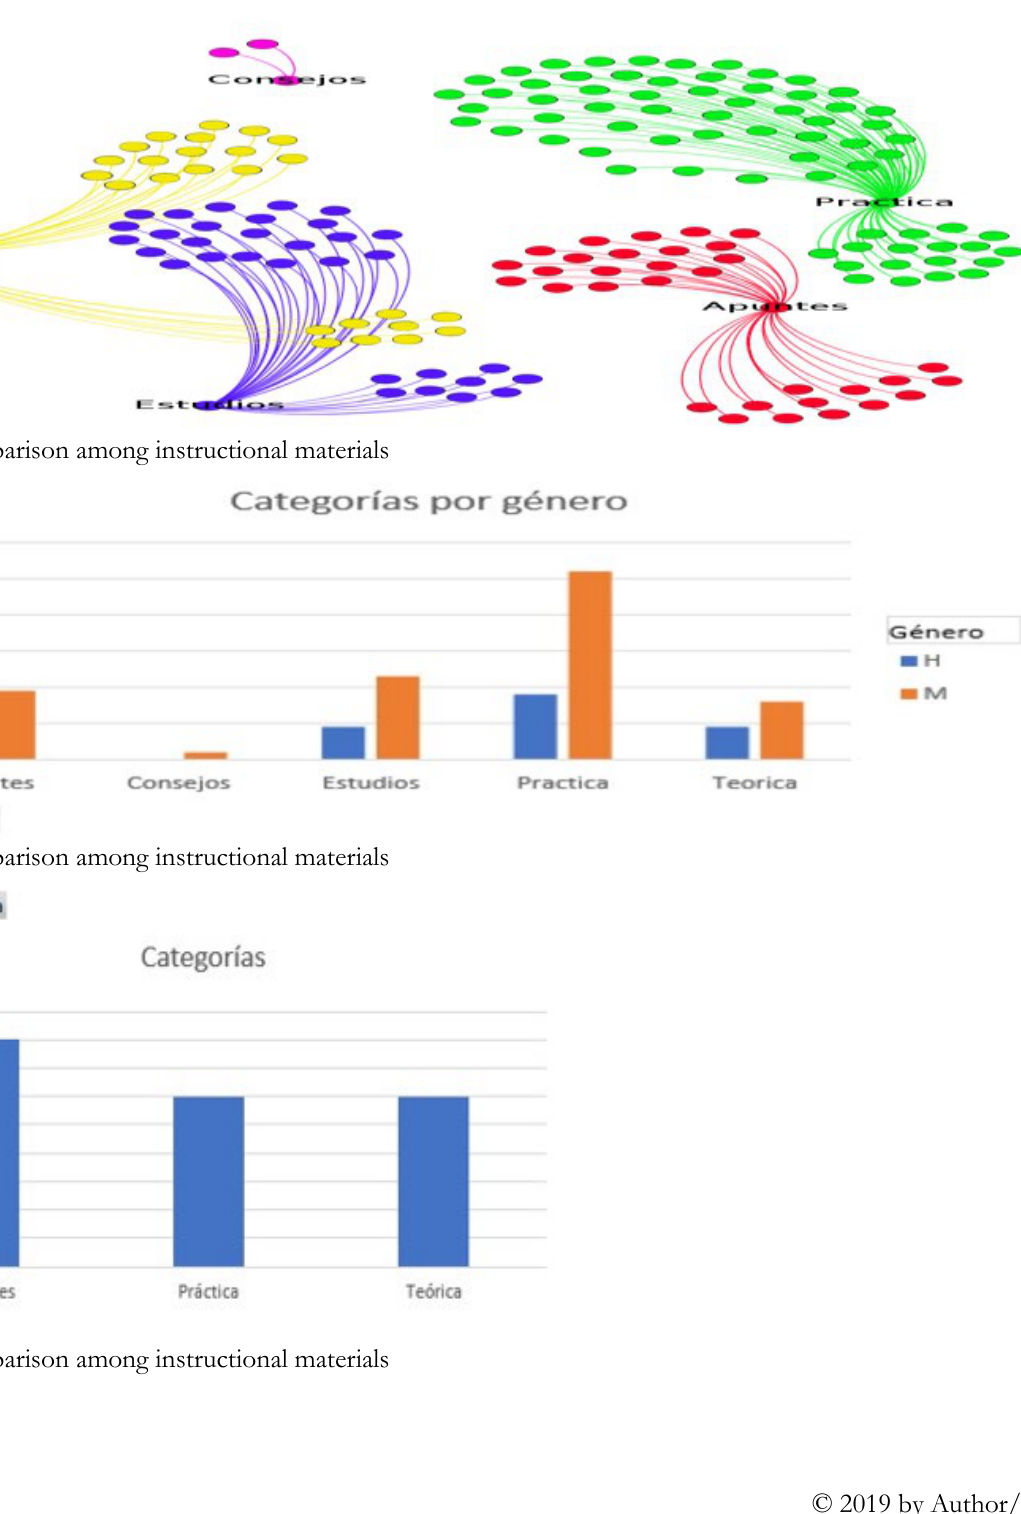
Figure 6. Female and male students and comparison among instructional materials